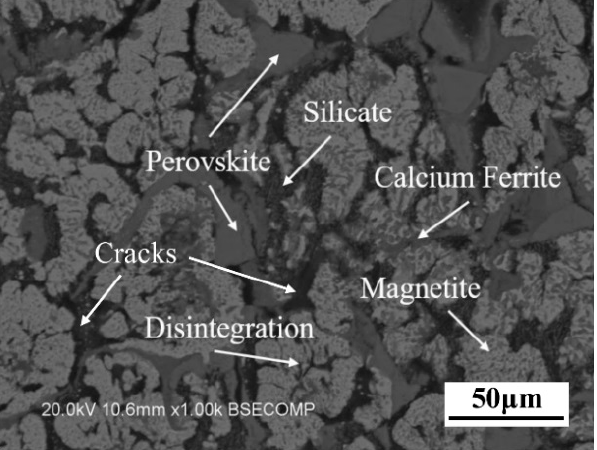
Figure 8. Reduction sinter at 500 °C for 60 min (basicity = 2.1).